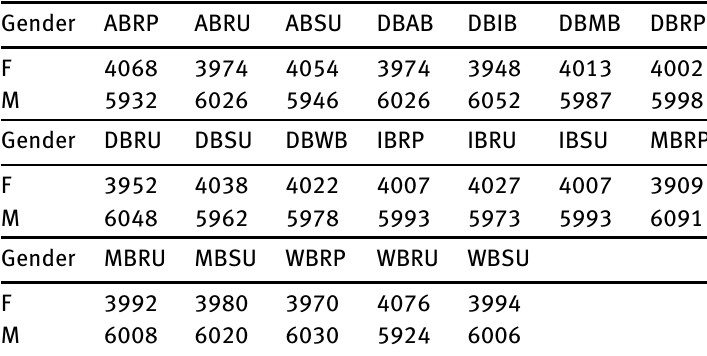
Table 6: Distribution of gender by product